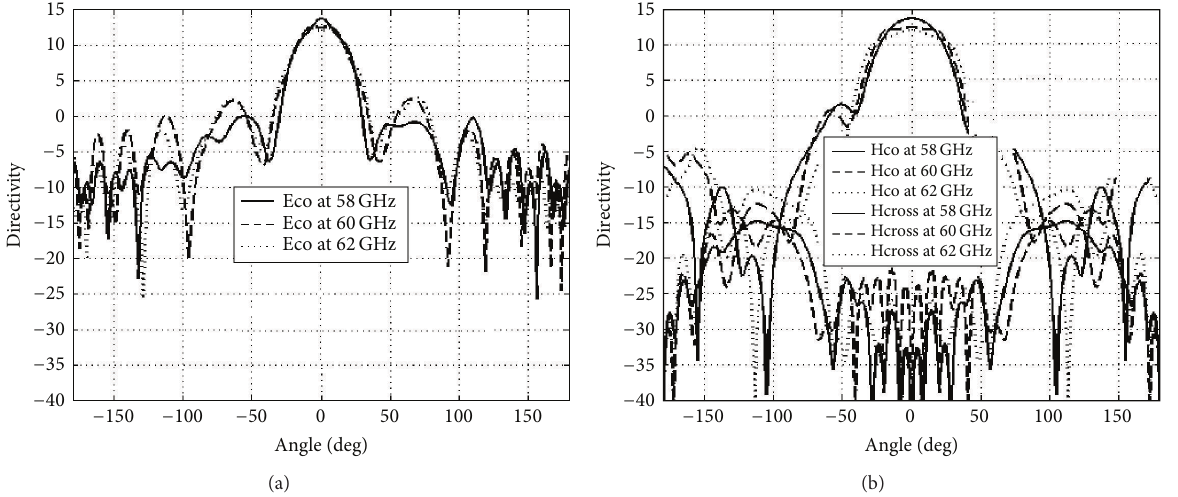
Figure 6: (a) Simulated 𝐸 -plane radiation pattern at 58, 60, and 62 GHz. (b) Simulated 𝐻 -plane radiation pattern at 58, 60, and 62